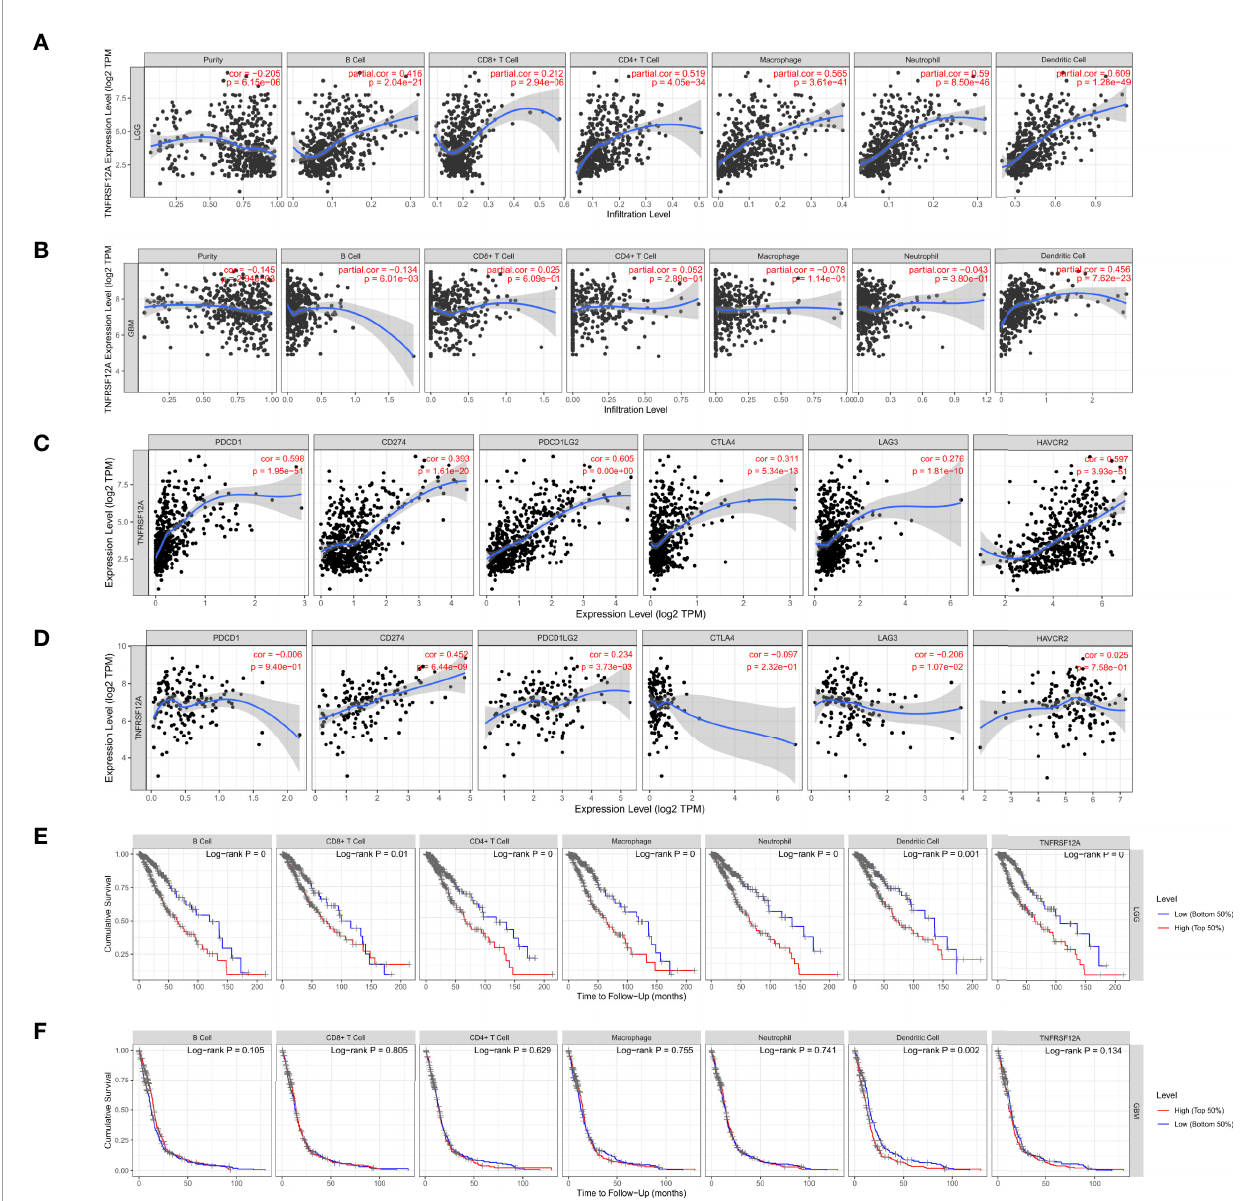
FIGURE 11 | (A) Correlation between TNFRSF12A expression in LGG and in fi ltration of six immune cells. (B) Correlation between TNFRSF12A expression in GBM and in fi ltration of six immune cells. (C) Correlation between TNFRSF12A and six classical immune checkpoints in LGG. (D) Correlation between TNFRSF12A and six classical immune checkpoints in GBM. (E) KM curve of LGG patient survival with TNFRSF12A expression and in fi ltration of six immune cells. (F) KM curve of GBM patient survival with TNFRSF12A expression and in fi ltration of six immune